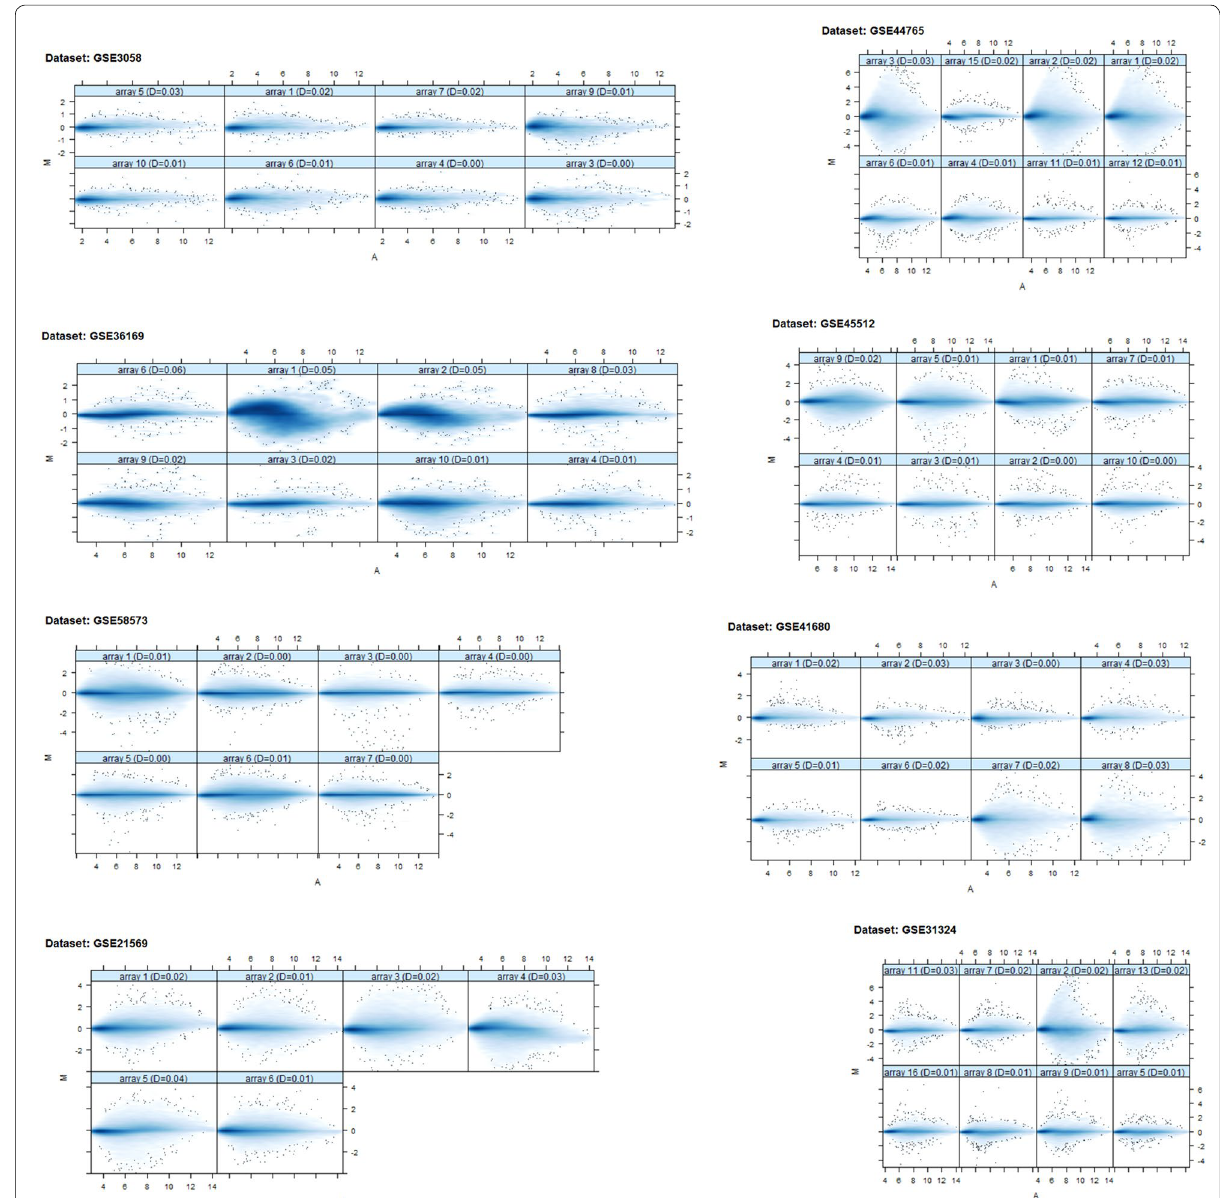
Fig. 1 MA plots: individual array quality of each dataset after normalization. M intensity of the array studied and I 2 is the intensity of a “pseudo-array” that consists of the median across arrays. Typically, we expect the mass of the distribution in an MA plot to be concentrated along the M